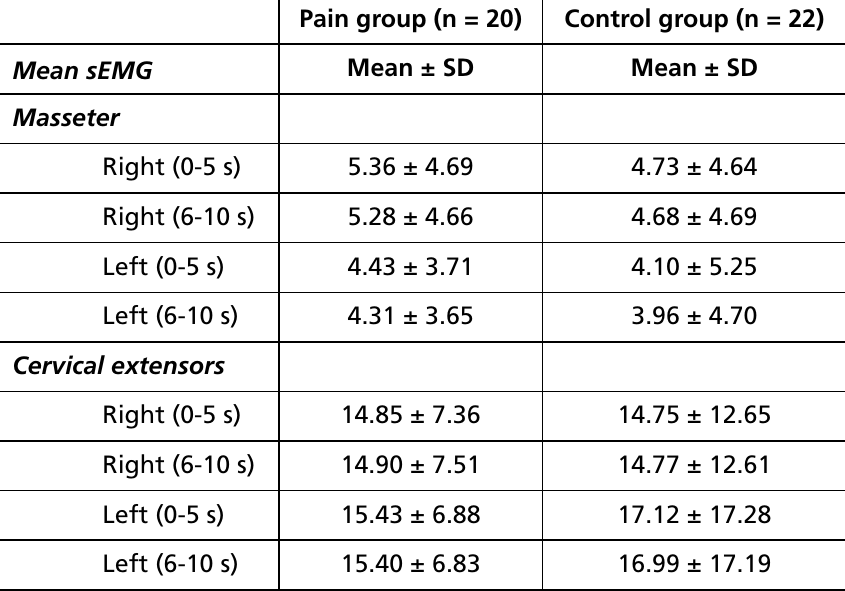
table 2: surface eMG data of masseter and cervical extensors at rest (n = 42)